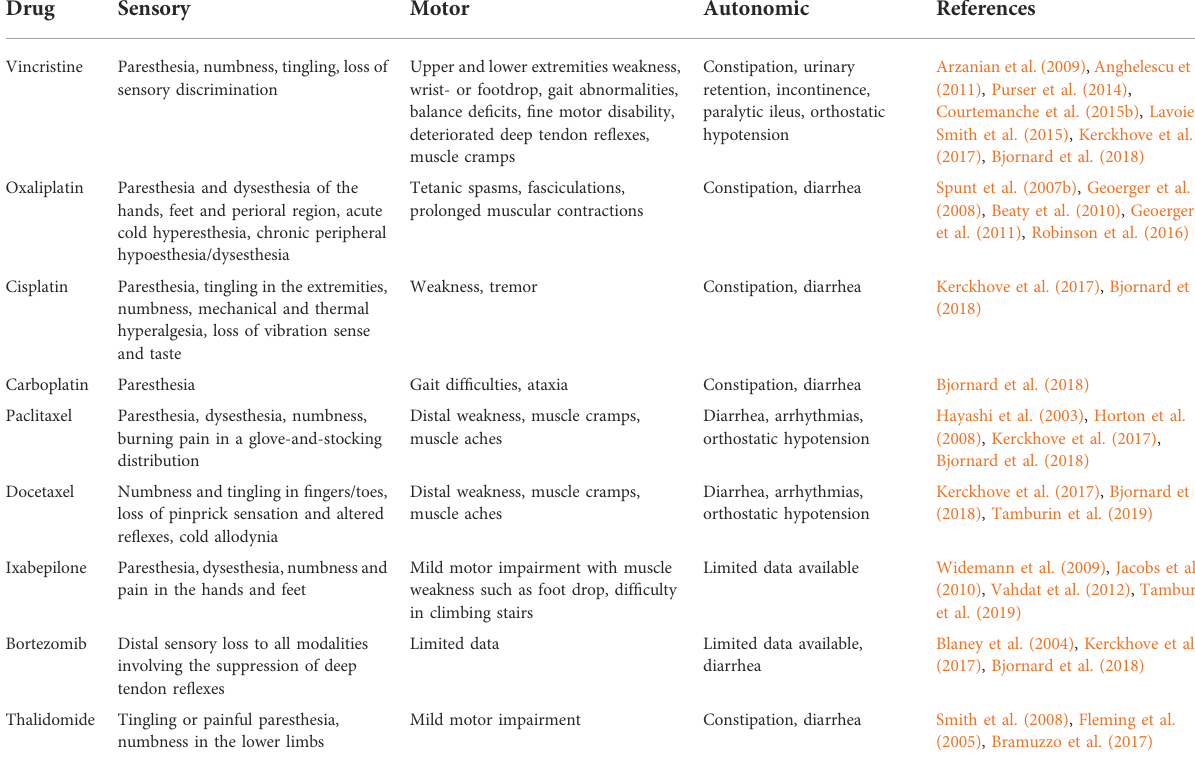
TABLE 3 Sensory, motor and autonomic symptoms of pediatric